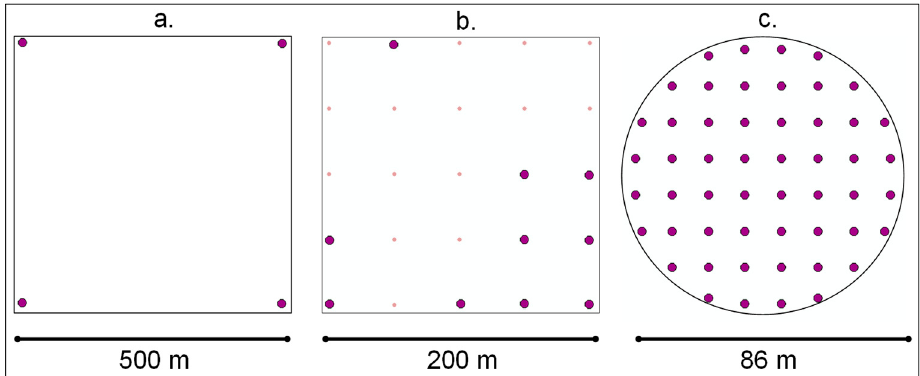
Figure 2. Plot designs for photointerpretation (PI)-based study. ( a ) The plot design for MD, which was chosen as part of a larger study. ( b ) The design for PG, which was chosen in order to achieve a roughly equal number of pairs of points per separation distance class. ( c ) The design for SC, which was chosen as part of a larger study on forest inventory precision.